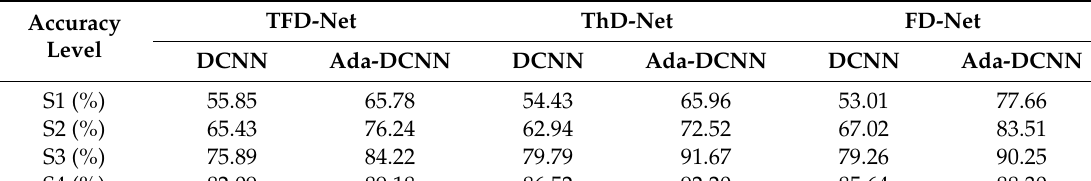
Figure 8. The final structure and related parameters of FD-Net.